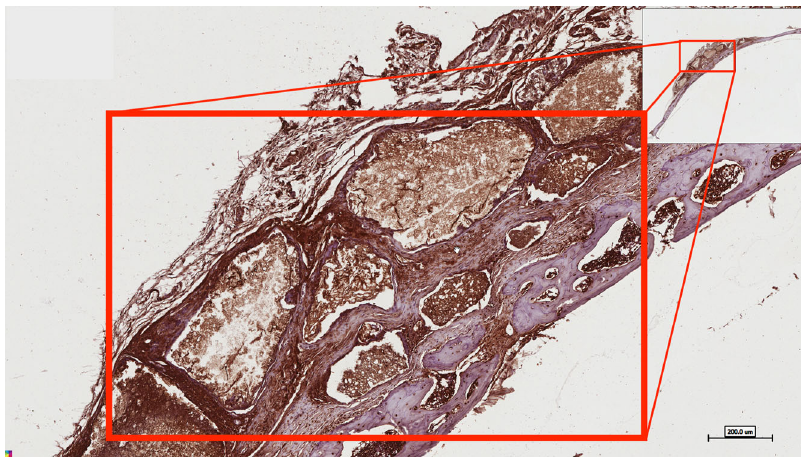
Fig. 8 Photomicrograph showing decalci fi ed sections of calvarial bones stained with haematoxylin and eosin (H & E). A Section of non- operated bone; the measured thickness = 280 µm. B Bone section after treatment with plain DSM; thickness = 282.80 µm. C Bone section